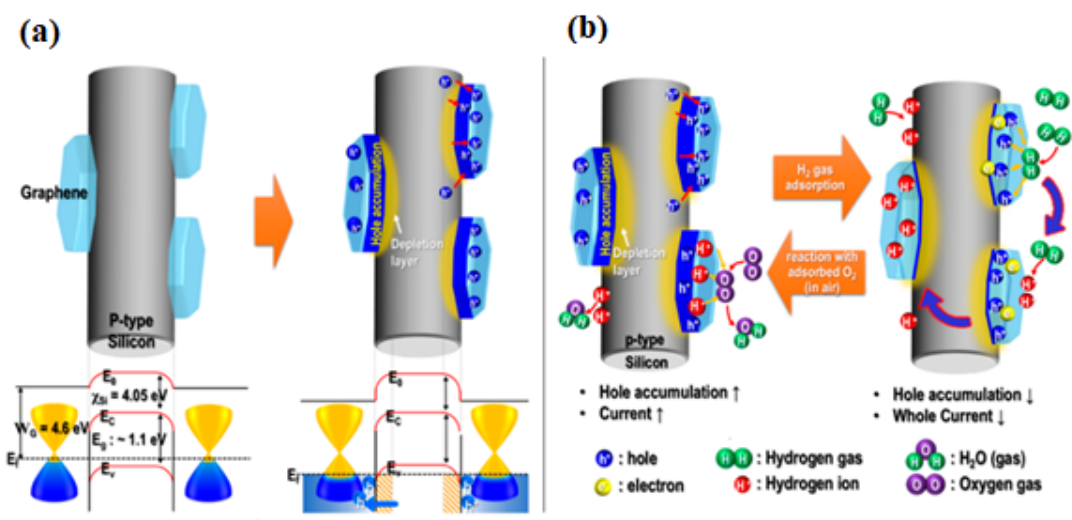
Figure 9. Schematic illustration showing ( a ) initial state of PSi / graphene substrate and formation of the depletion layer, ( b ) the adsorption-desorption process of H 2 [194].